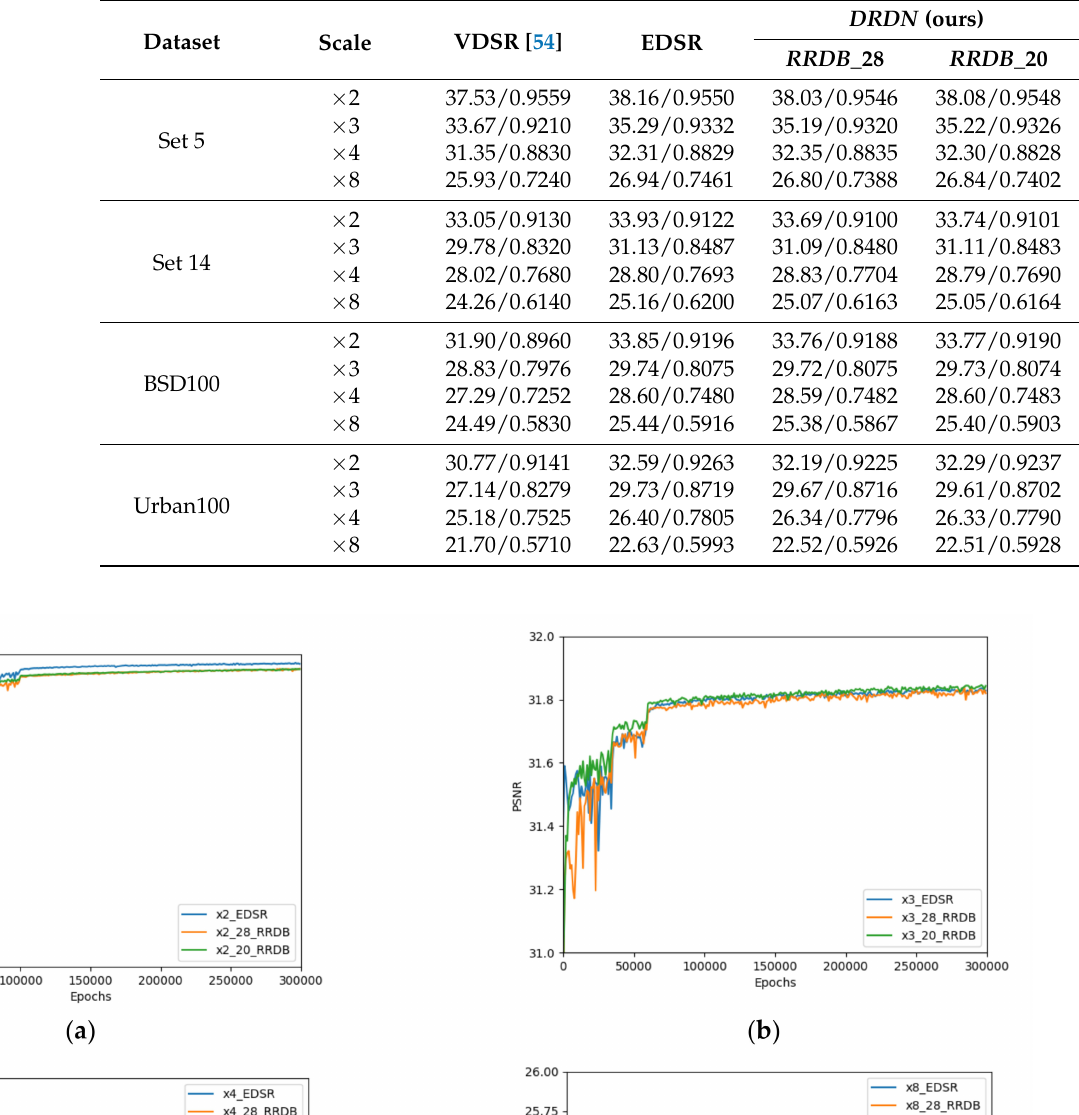
Table 4. Public benchmark test results (peak signal-to-noise ratio (PSNR) (dB)/structural similarity